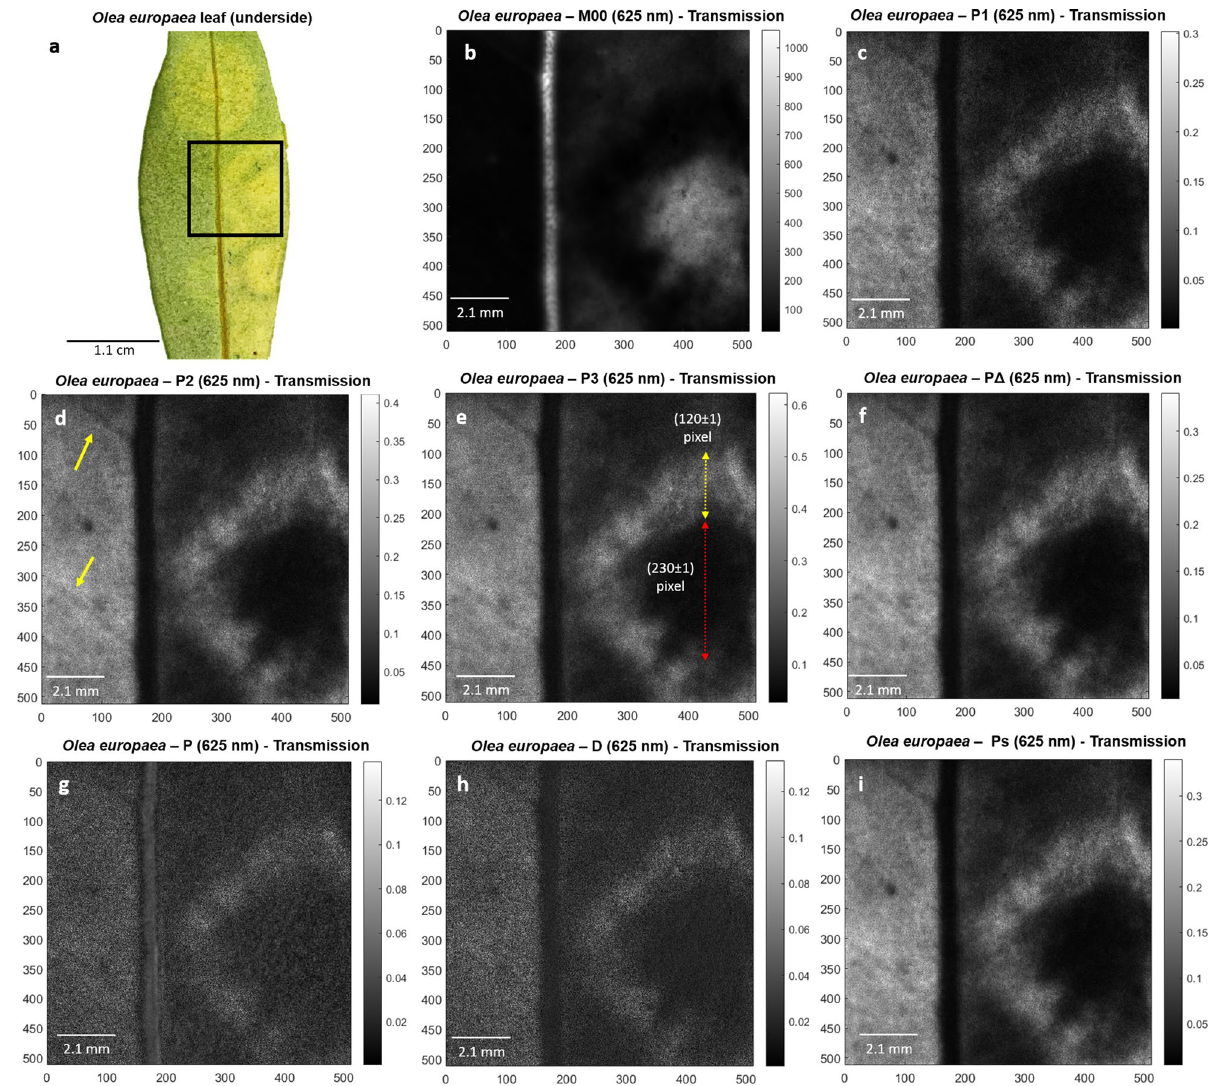
Figure 2. Polarimetric images of Olea europaea leaf used in this study. ( a ) Picture of the underside part of O. europaea leaf. Black square denotes for selected region of interest (ROI) analyzed in remaining images, ( b ) regular intensity image (M 00 ) of the O. europaea transmission ROI and its corresponding polarimetric observables ( c ) P 1 , ( d ) P 2 , ( e ) P 3 , ( f ) P Δ , ( g ) P , ( h ) D and ( i ) P S for visual comparison. All images correspond to 625 nm illumination wavelength measurements performed at transmission set-up configuration. Red and yellow dotted lines correspond to diameter and width measurements for chlorotic spot and necrotic ring, respectively. Yellow arrows indicate the unveiled vascular